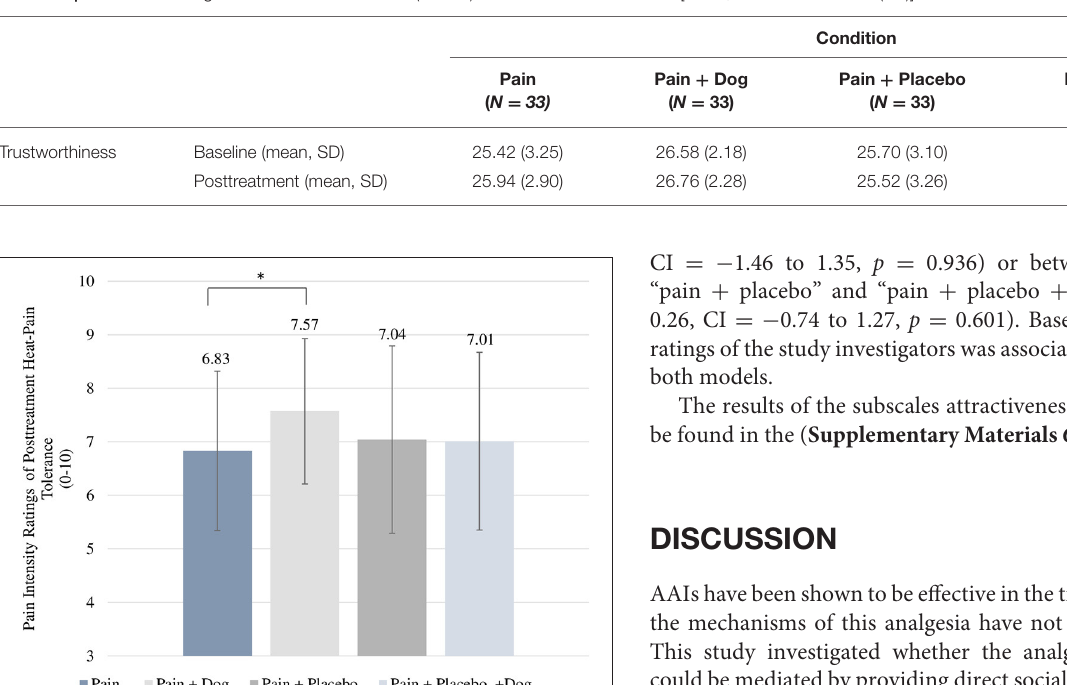
TABLE 3 | Counselor Rating Short Form Questionnaire (CRF-S): Subscale Trustworthiness [mean, standard deviation (SD)].